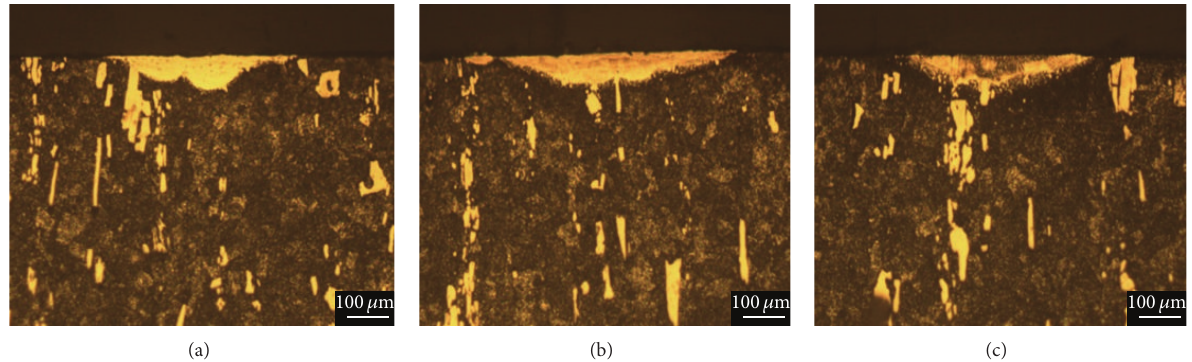
Figure 6: Cross-sectional views of a single-line bead hardened at underwater condition. Scanning rates are (a) 7.32 mm/s, (b) 14.64 mm/s, and (c) 21.96mm/sec. Laser power is constant (150W).